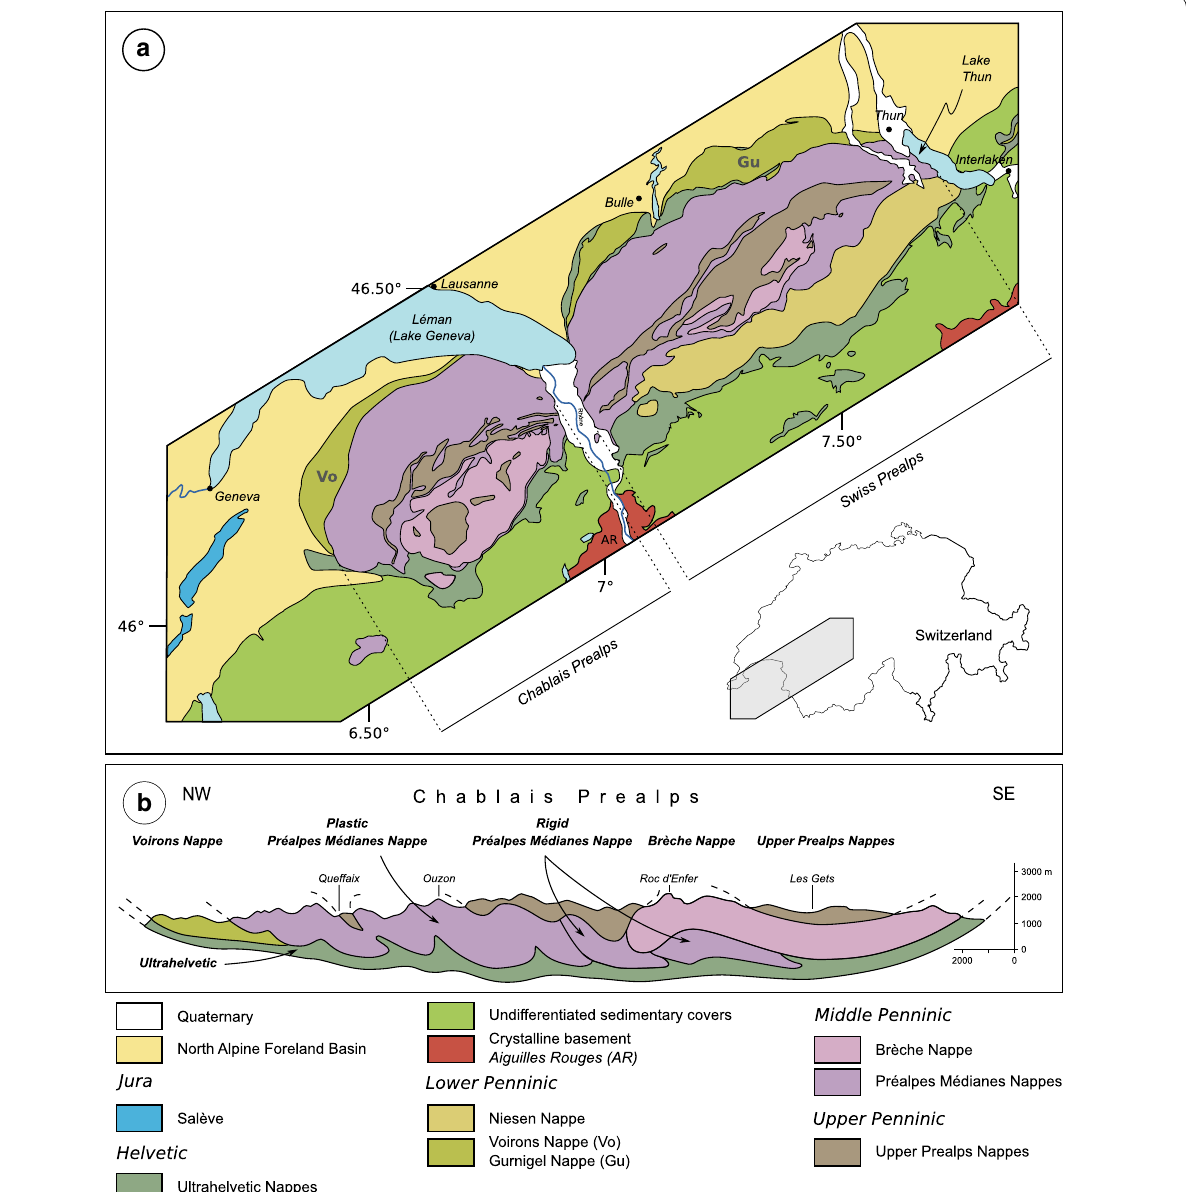
Fig. 1 Geological setting of the Voirons Nappe. a Simplified tectonic map of the Chablais and Swiss Prealps (SwissTopo 2008, modified). The internal subdivision of the Préalpes Médianes Nappe are not shown. Note the external location of the Voirons Nappe within the Chablais Prealps. b Synthetic cross‑section of the Chablais Prealps from Caron (1973,